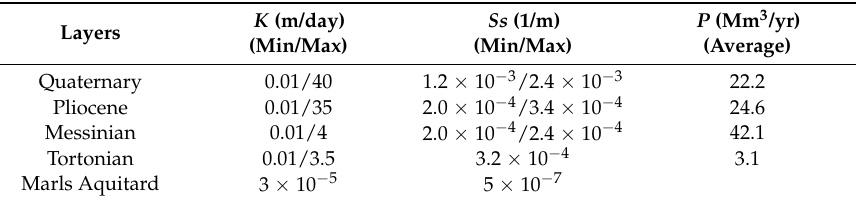
Table 3. Calibrated parameters in the transient state.